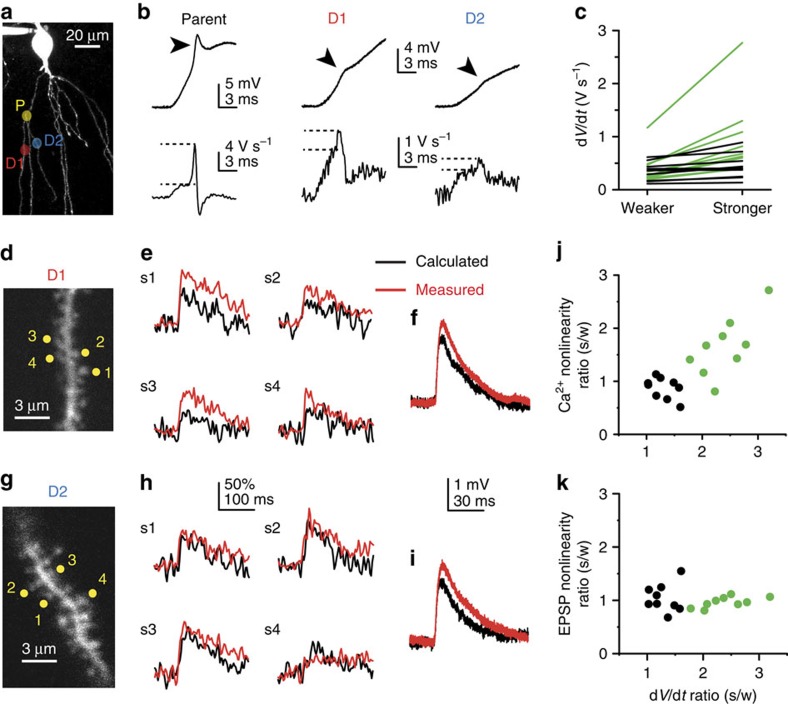
Spine Ca2+ cooperativity correlates with dendritic Na+ spike strength.(a) Partial 2P z-stack of a CA1PC, with stimulation sites on terminal sister dendrites (D1 and D2) branching off from a common parent dendrite (P) indicated. (b) Representative voltage traces (upper) and corresponding dV/dt (lower) of dendritic Na+ spikes (pointed at by arrowheads) evoked at the stimulation sites in the three dendrites indicated in a (see Methods). Note that parent branch spike is much stronger than daughter branch spikes. All dendritic families used in the analysis had parent branch spike with dV/dt>2 V s−1. (c) Comparison of dendritic Na+ spike strength between terminal sister branches. Black: dV/dtstronger branch/dV/dtweaker branch<1.7 (n=9); green: dV/dtstronger branch/dV/dtweaker branch>1.7 (n=9). (d) Stimulated spine set in D1 shown in a and b. (e) 4S protocol on the four spines in D1 shown in d. (f) Somatic EPSP nonlinearity corresponding to the experiment in e. (g–i) same as d–f but in D2 shown in a and b. (j,k) Ratio of spine Ca2+ nonlinearity (j, Spearman R=0.671, P<0.05, n=18) and somatic EPSP nonlinearity (k, Spearman R=−0.003, P=0.990, n=18) by the 4S protocol in connected sister branches, as a function of the ratio of their dV/dt (Na+ spike strength). Black and green dots indicate homogenous and heterogeneous pairs, respectively.